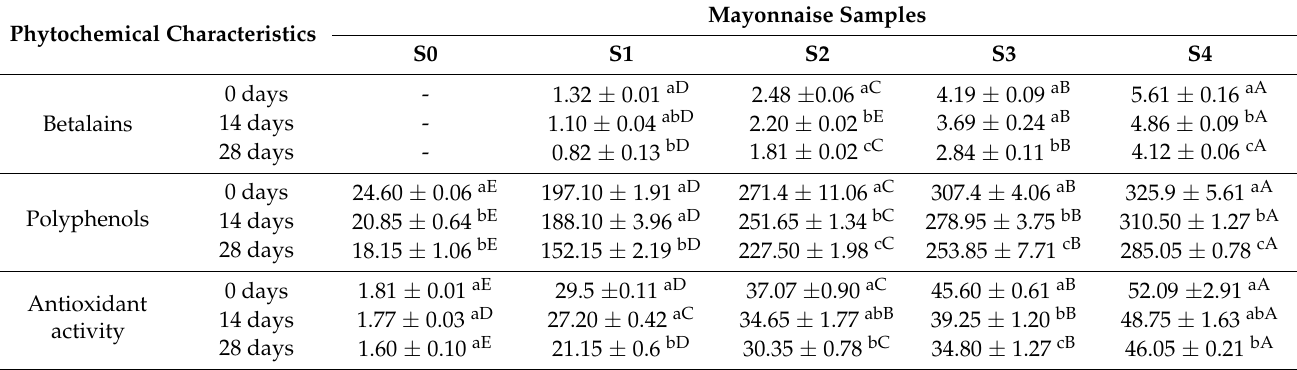
Table 2. Phytochemical characteristics (mg/100 g) and antioxidant activity (mM Trolox/100 g) of mayonnaise enriched with beetroot peel powder